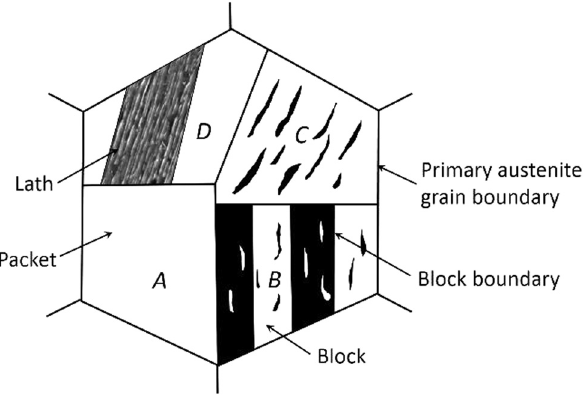
Figure 2: Schematic of lath martensite structure of low carbon steel.